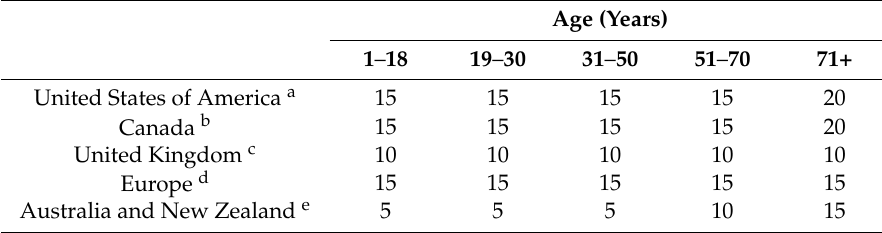
Table 1. Examples of recommended daily intakes of vitamin D ( µ g/day) across different regions.